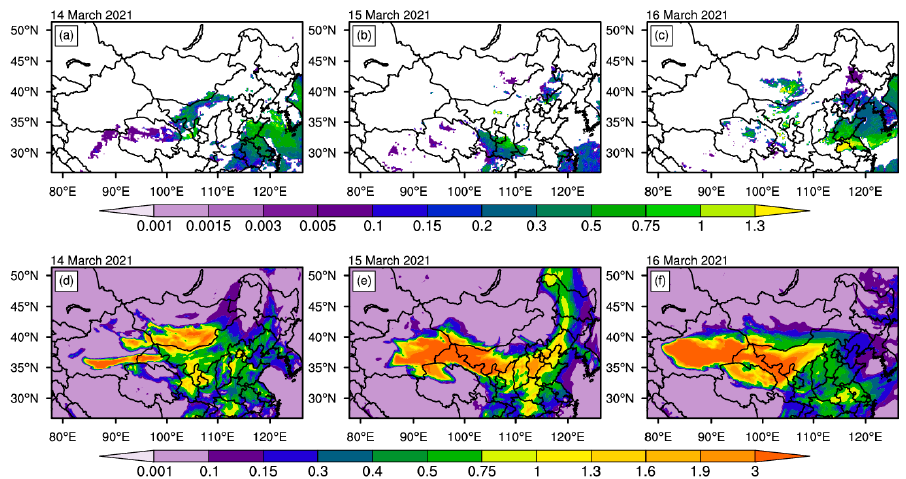
Figure 8. Spatial distributions of the daily mean AODs obtained by the Himawari-8 observations ( a – c ) and the WRF-Chem simulations ( d – f ) on 14–16 March 2021.